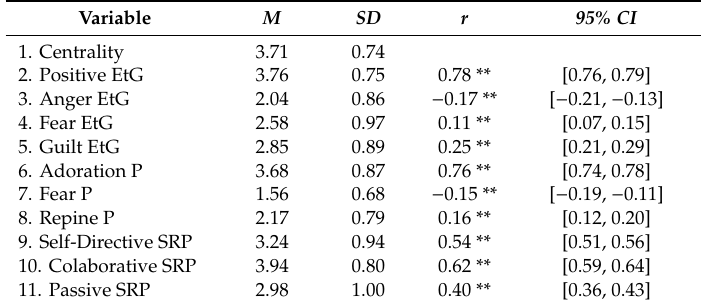
Table 2. Means, standard deviations, and correlations with centrality with confidence intervals of variables in the study ( n =